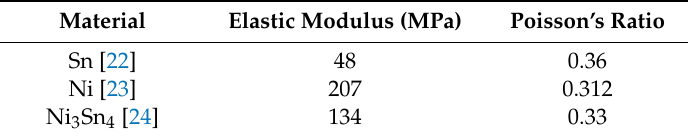
Table 2. Elastic material properties of the materials used in FE